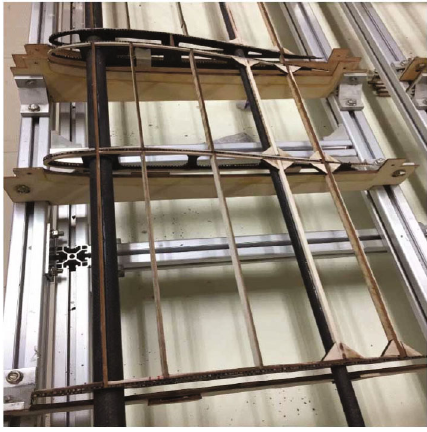
Figure 21: Internal structure of prototype wing.